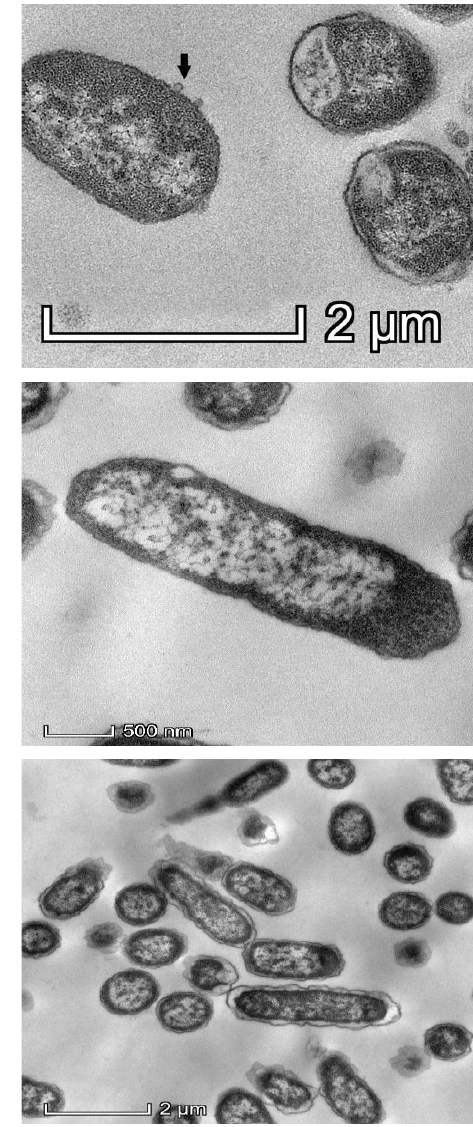
Table 2. General characteristics of the eight bacteriophages.